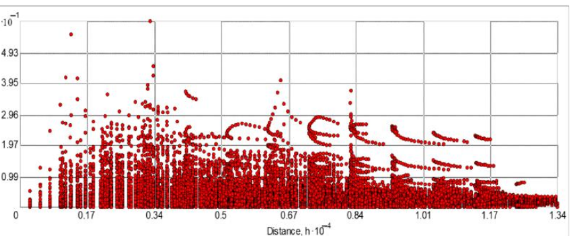
Figure 11. The semivariogram graph of the predicted points for average CO 2 variation with distance, obtained from the spline tension interpolated